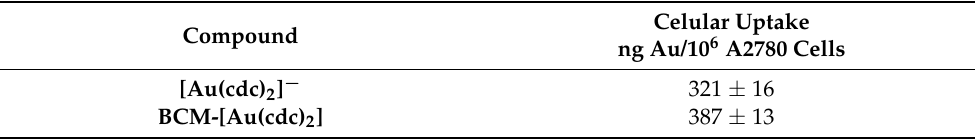
Table 6. Cellular uptake of Au in whole A2780 cells as determined by PIXE. Cells were previously incubated with the compounds at 9 µ M for 3 h. The Au levels in the whole cells are expressed as ng Au/10 6